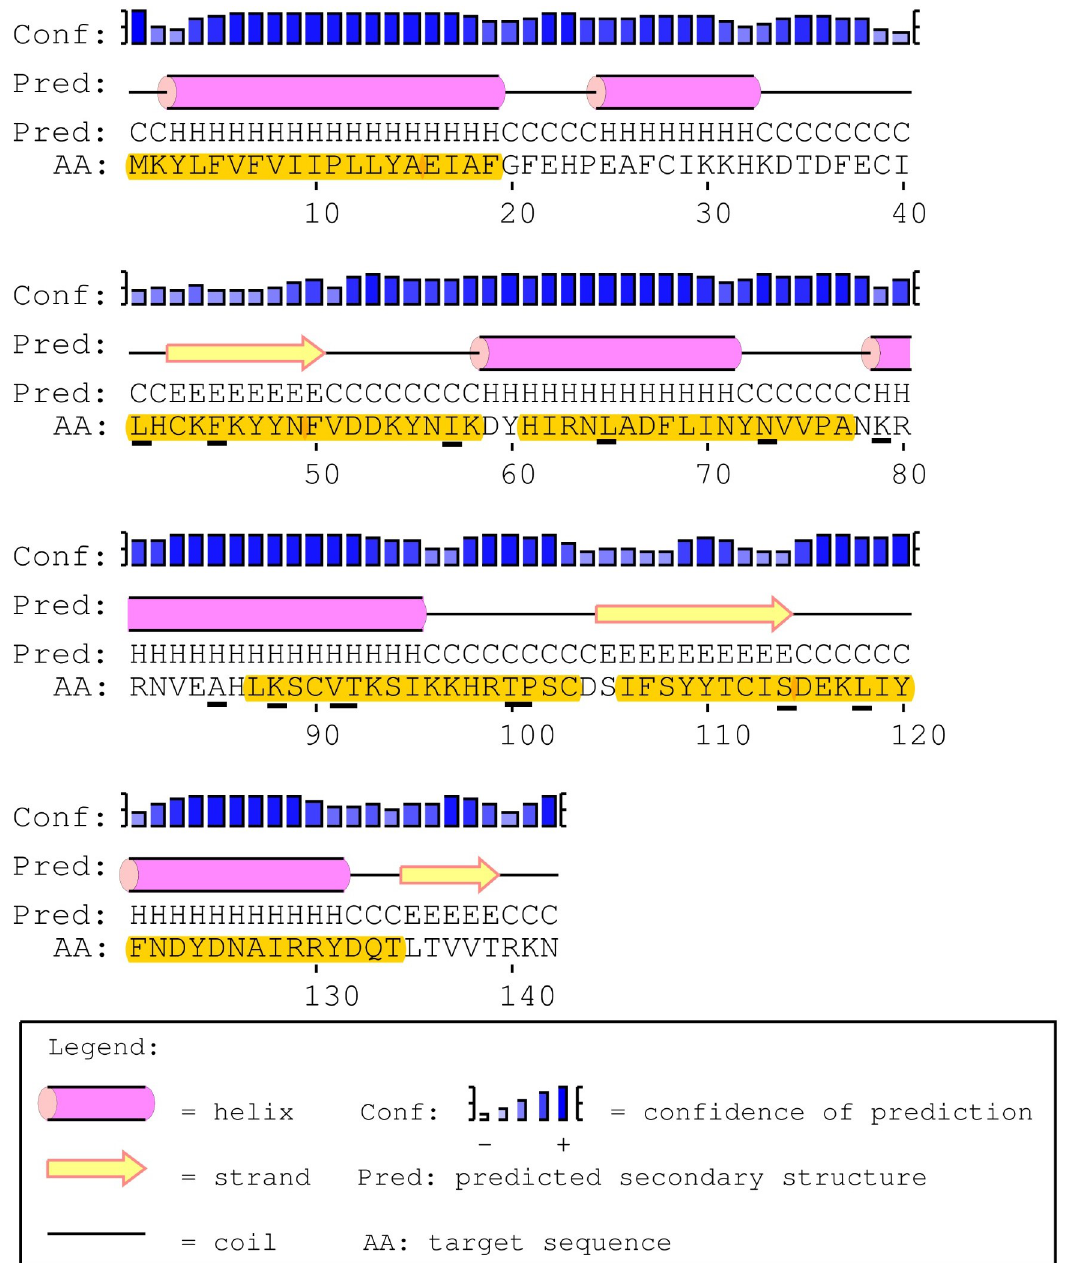
Fig 7. PpSp14 secondary structure, polymorphic sites, and MHC class II epitope predictions. The mature PpSP14 amino acid sequence predicted secondary structure. Yellow highlighted amino acids indicate the predicted MHC class II predicted promiscuous peptides. Individual amino acids underlined in black indicate unique polymorphic sites. Predicted secondary structure based on sequence accession #AGE83089 [51].